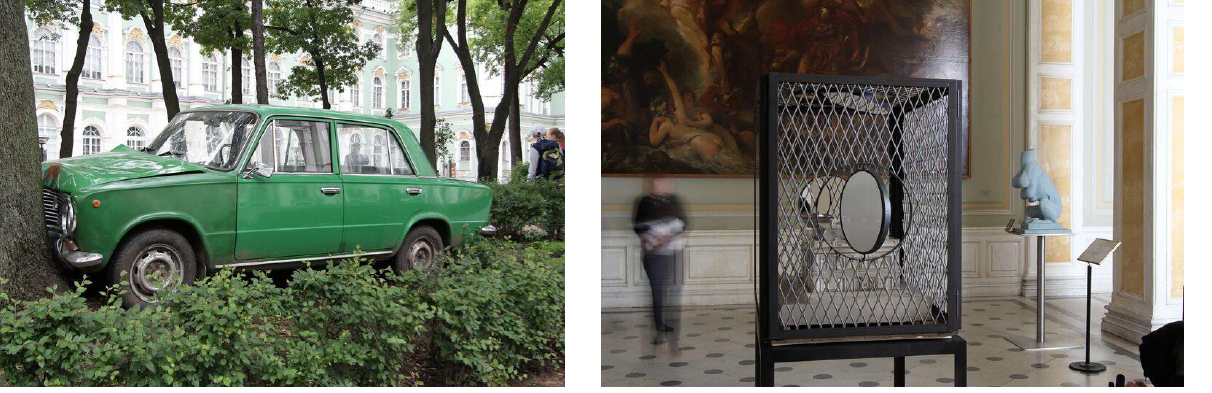
Figure 1 | Francis Alÿs in collaboration with brother Frédéric, Constantin Felker, and Julien Devaux. Lada “Kopeika” Project . Brussels—St. Petersburg (2014). Commissioned by MANIFESTA 10, St Petersburg. With the support of the Flemish authorities.